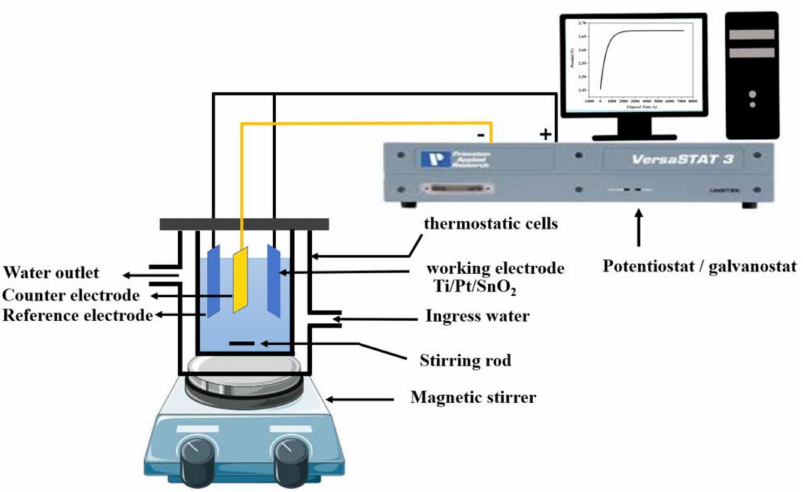
Figure 2. Schematic representation of the electrochemical